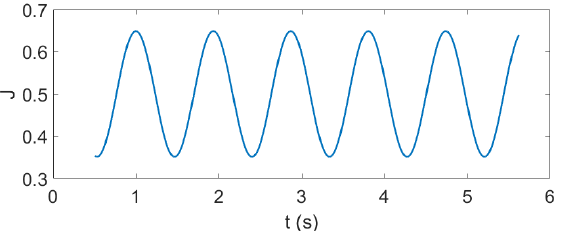
Figure 19. J as a function of time for behind condition Test